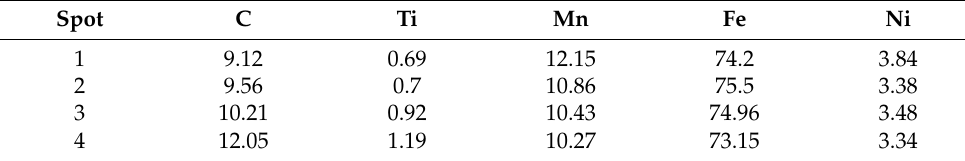
Figure 3. SEM characterization with different heat input ( a ) sintered; ( b ) 3.4 KJ/cm; ( c ) 6.2 KJ/cm; ( d ) 7.9 KJ/cm. Spots 1–4 represent the EDS points. Table 3. EDS spot analysis of bonding phase